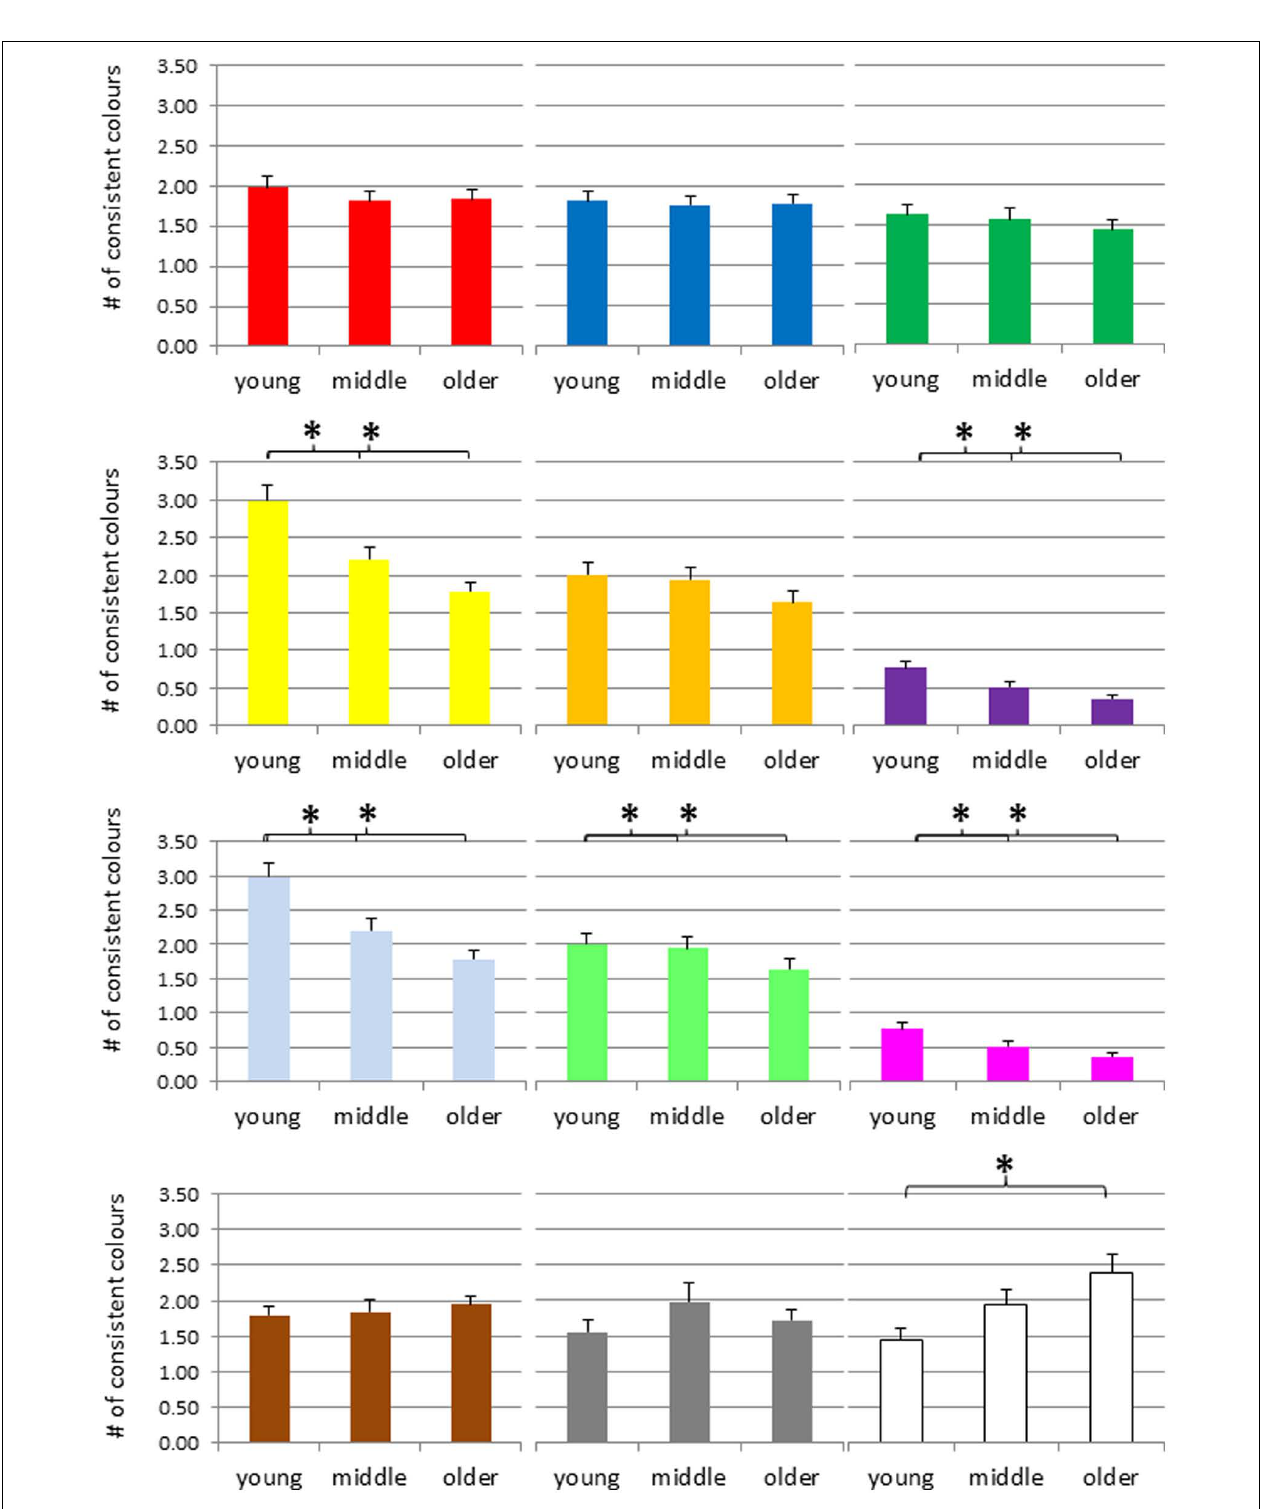
FIGURE 5 | Number of consistent colors for letters across the adult lifespan, separately for each color (red, blue, green, yellow, orange, violet, light-blue, light-green, magenta, brown, gray, and white, from top left to bottom right). * p < 0.05, # = number.